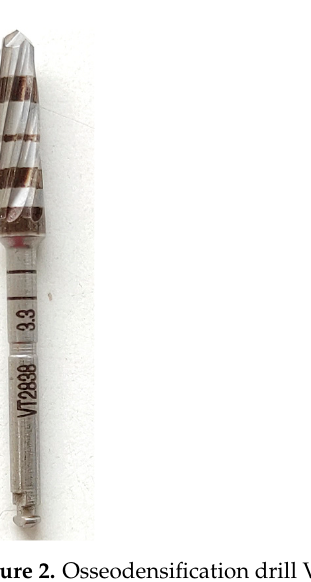
Figure 1. Dental Implant with morse tapper connection (Implacil de Bortoli, São Paulo, SP-Brazil).